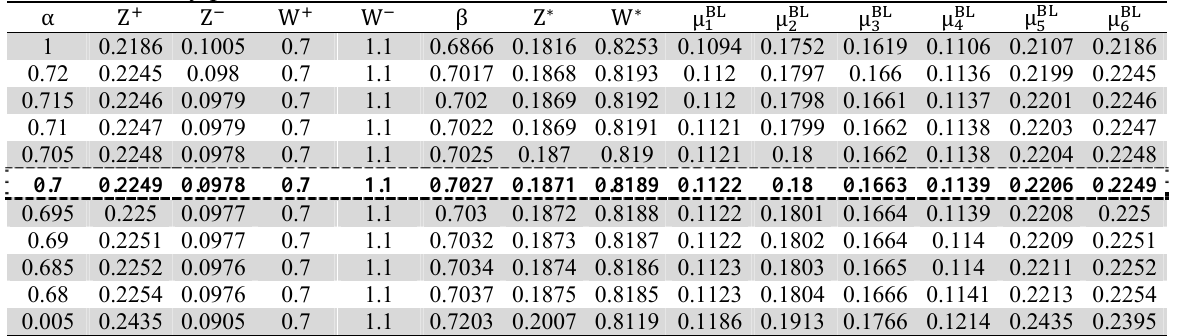
Results for fuzzy problem